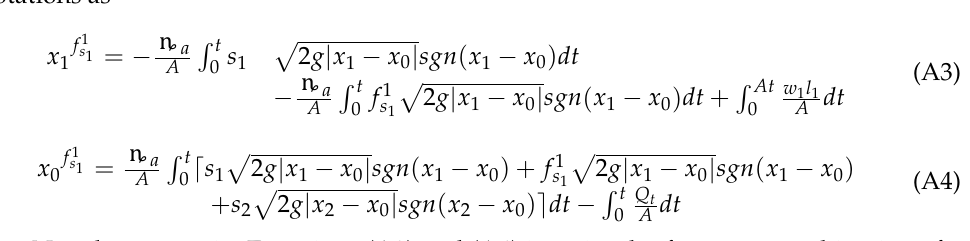
Figure 1. Three-pond hydraulic system.